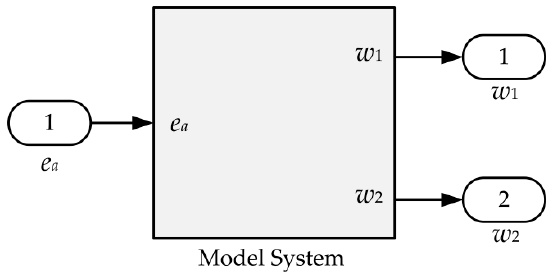
Figure 3. Parameter identification model of the flexible-joint robot system.